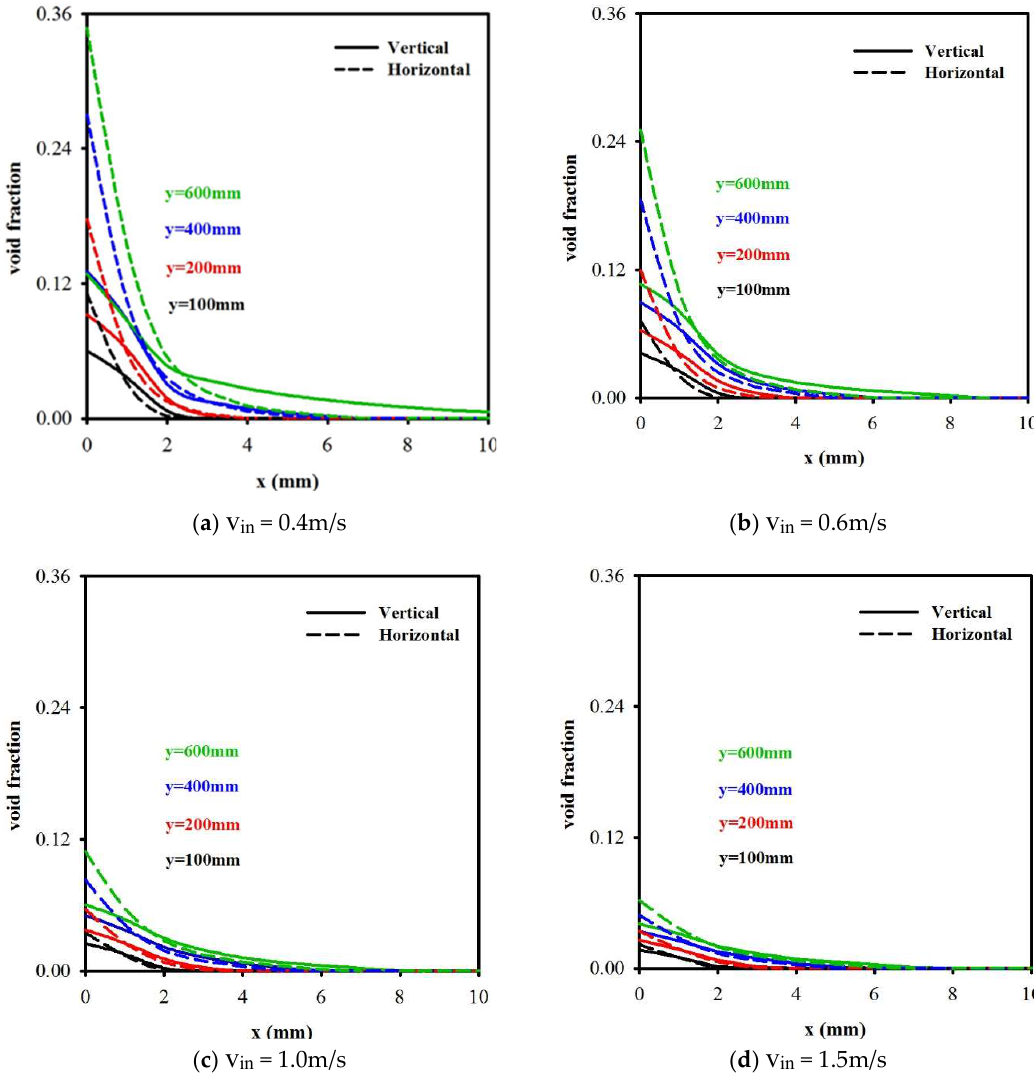
Figure 6. The void fraction distribution vs. x for different v in and y for a vertical cell and a horizontal cell.